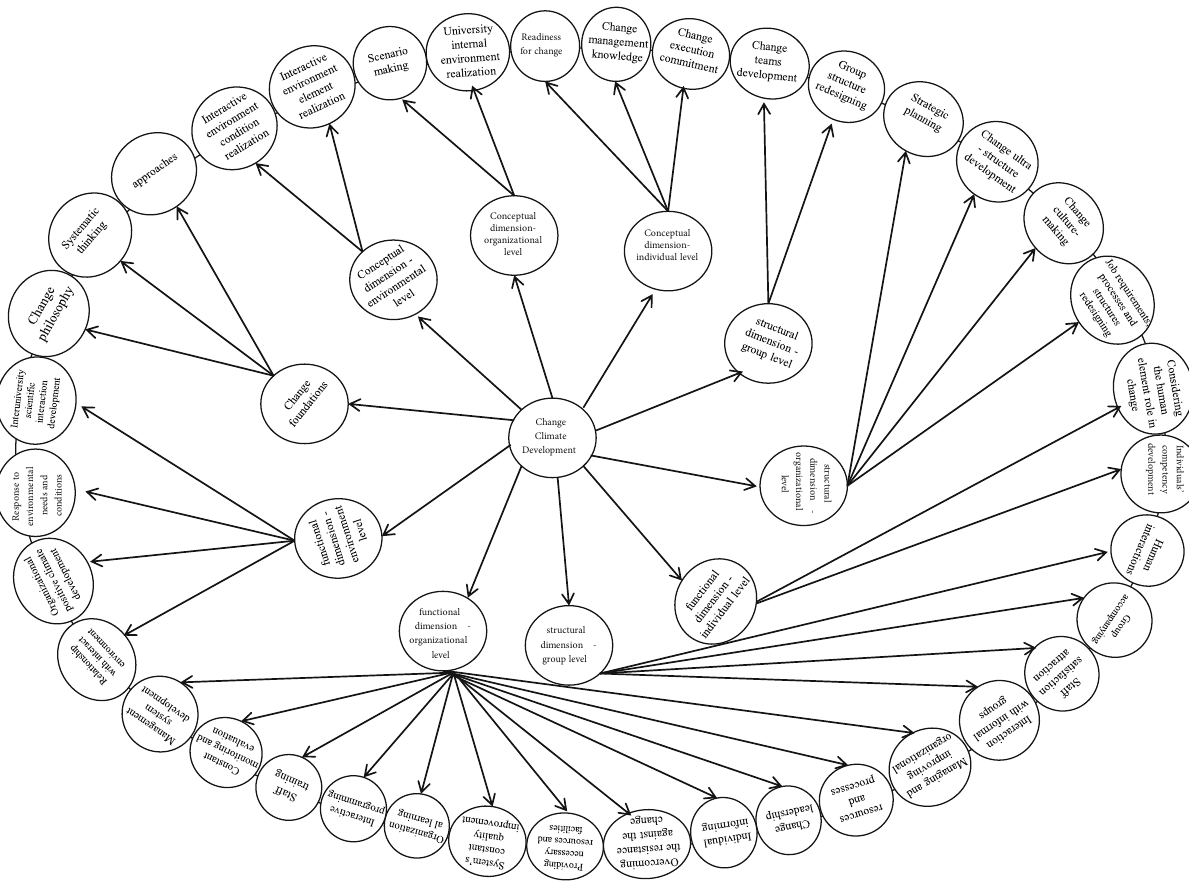
Figure 1: The relationship between organizing themes in the NVivo software.